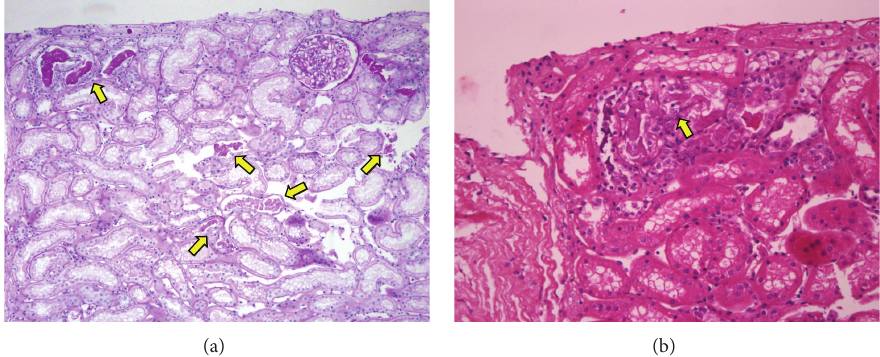
Figure 1: Light microscopic findings. (a) Low power view reveals break downs of tubules due to tubular cast (arrow; PAS × 100). (b) Light microscopic findings show necrotic and sloughed tubular cells in the tubular lumina. Regenerating tubular epithelial cells are noted with mitotic figures (arrow; hematoxylin and eosin × 200).